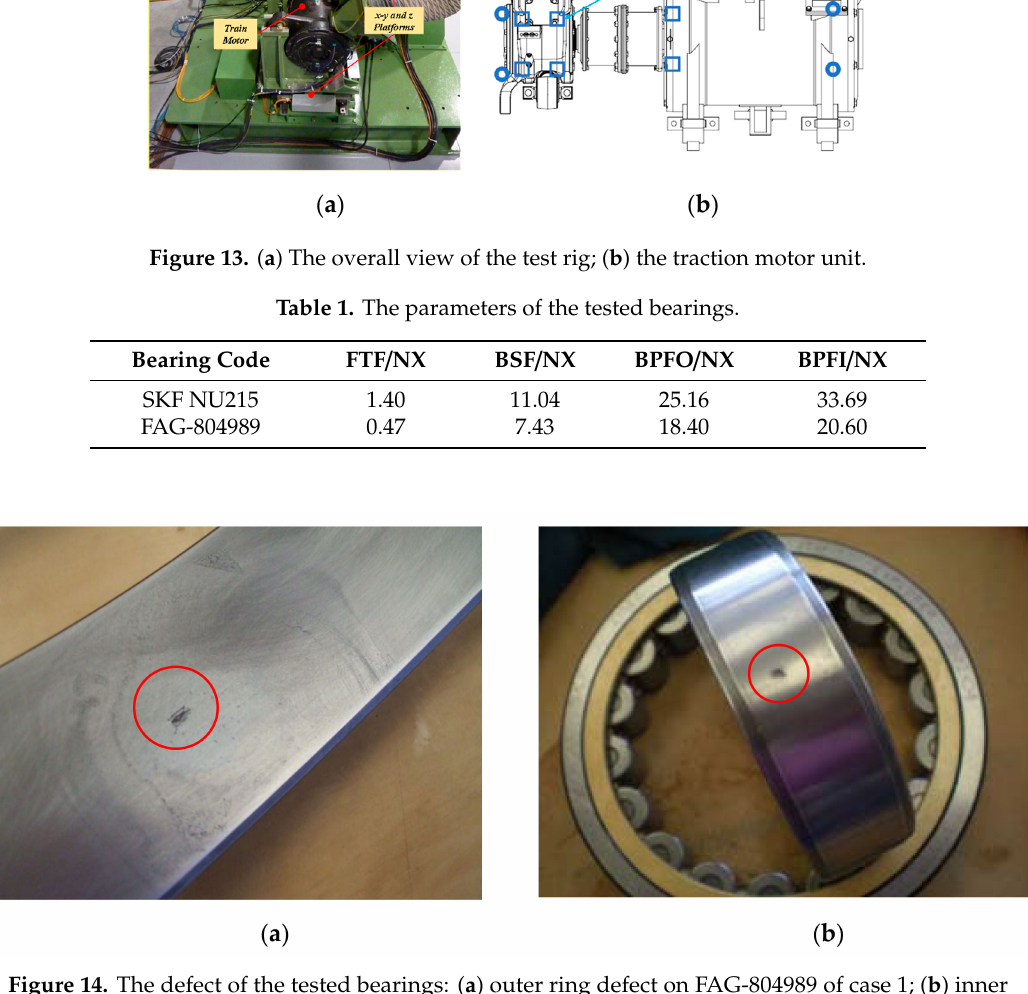
Figure 14. The defect of the tested bearings: ( a ) outer ring defect on FAG-804989 of case 1; ( b ) inner ring defect on SKF NU215 of case 2.